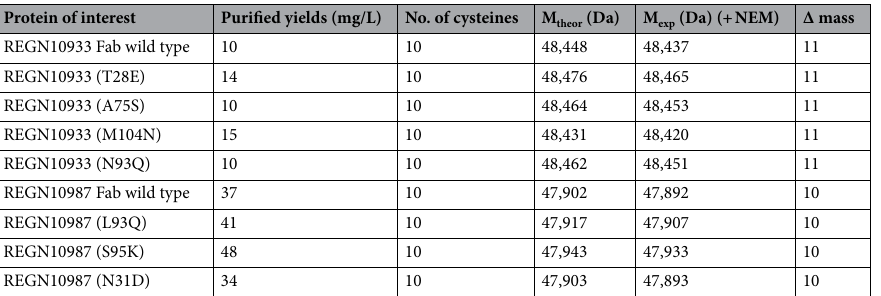
Table 2. Protein yields and molecular weight analysis of purified wild-type Fabs and their variants by electrospray ionization mass spectrometry (ESI–MS) under NEM treated conditions. Formation of one disulfide bond accounts for a mass difference of 2 Da in the experimental molecular weight (M exp ) from the theoretical molecular weight (M theor ). No NEM binding (+ 125 Da) was observed for any of the samples analyzed. The observed masses suggest that all cysteines are in disulfide